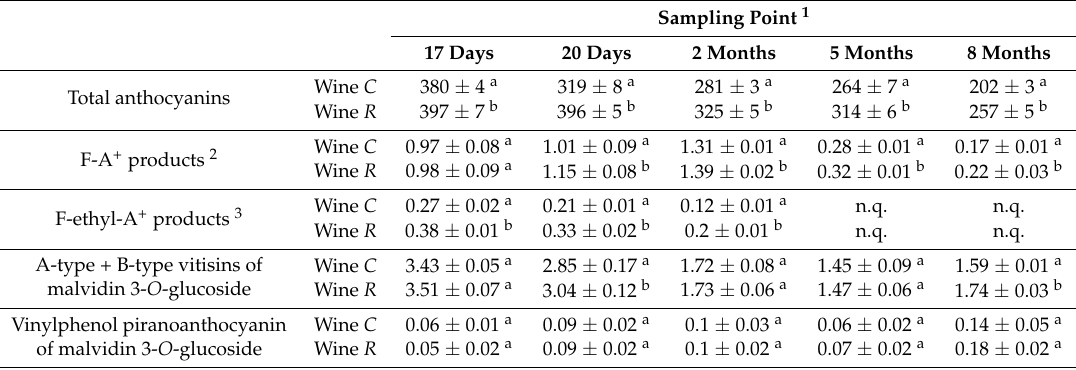
Table 4. Evolution of the pigment composition in wines C and R (mg/L, quantified as equivalents of malvidin 3- O